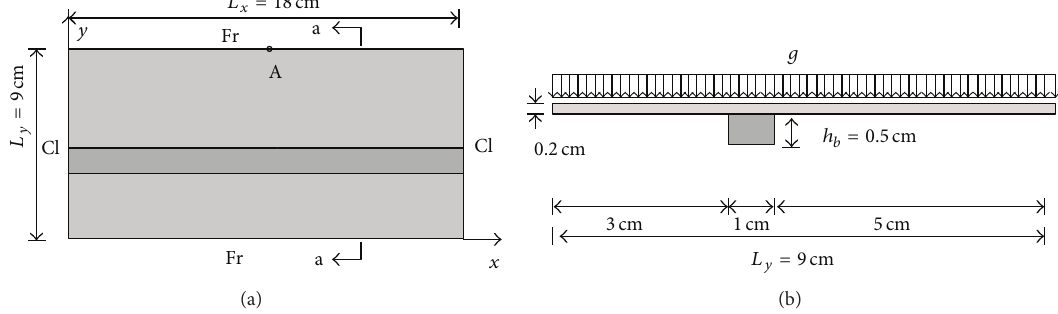
Figure 4: Plan view (a) and section a-a (b) of the stiffened plate of Example 1.